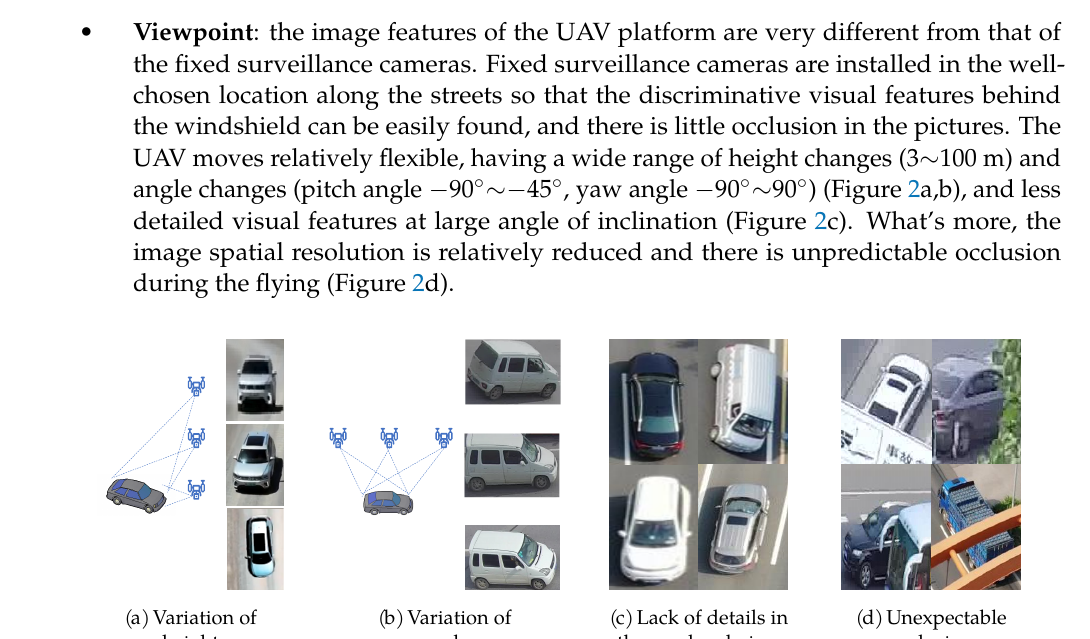
Figure 1. Different datasets for different tasks and captured by different platform.